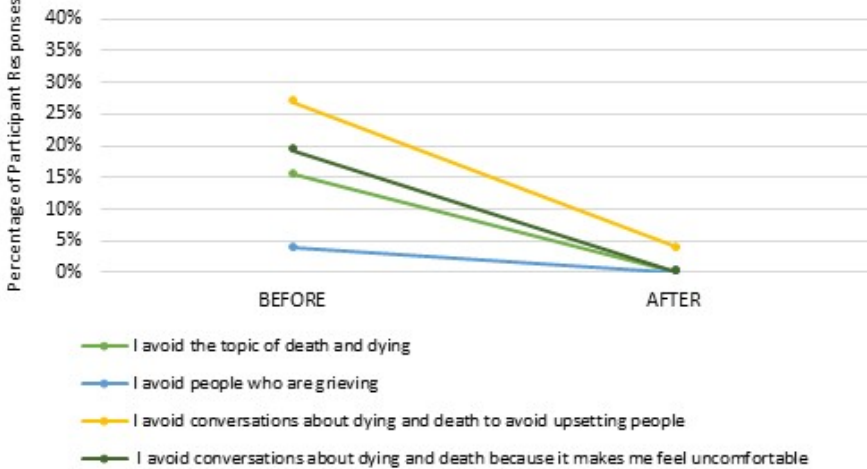
Figure 1. Talking about Death and Dying.